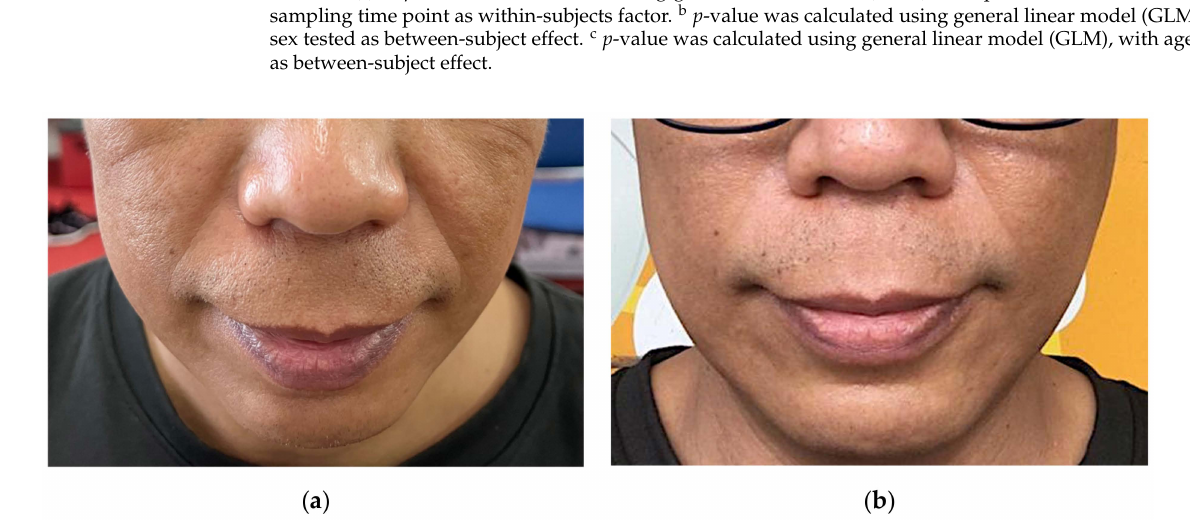
Figure 2. Photographic images of nasolabial folds of a representative patient ( a ) before supplementa- tion; WSRS grade 3, and ( b ) at 3 months after rice ceramide supplementation; WSRS grade 2.